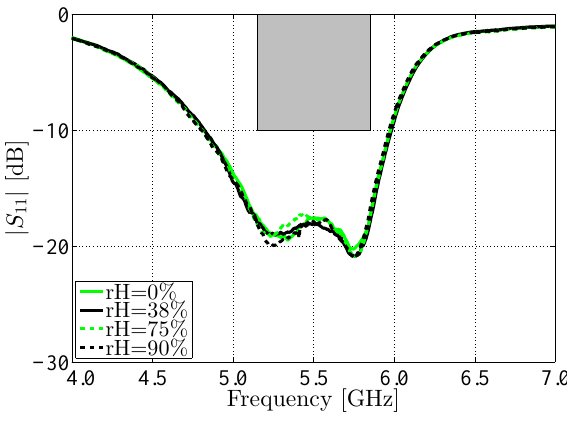
Figure 17. Magnitude of the reflection coefficient of the measured antenna for different relative humidities, with respect to a 50 Ω reference